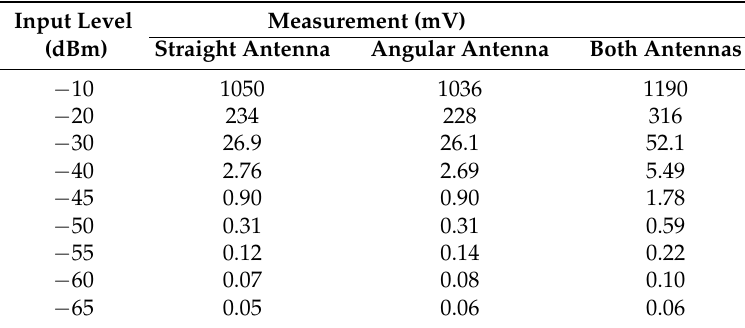
Output voltage of rectifier at decreasing input signal levels using different antenna configurations.